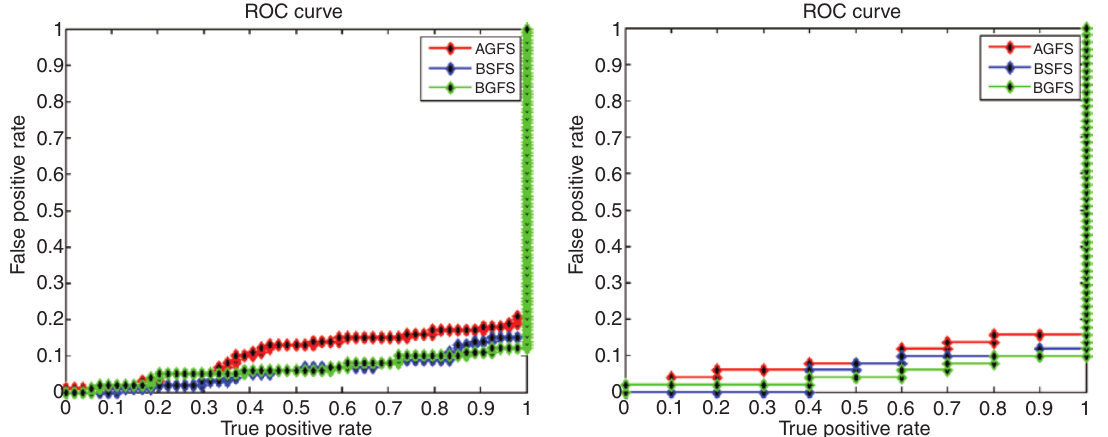
Figure 10: ROC Curve for PID and Cleveland.